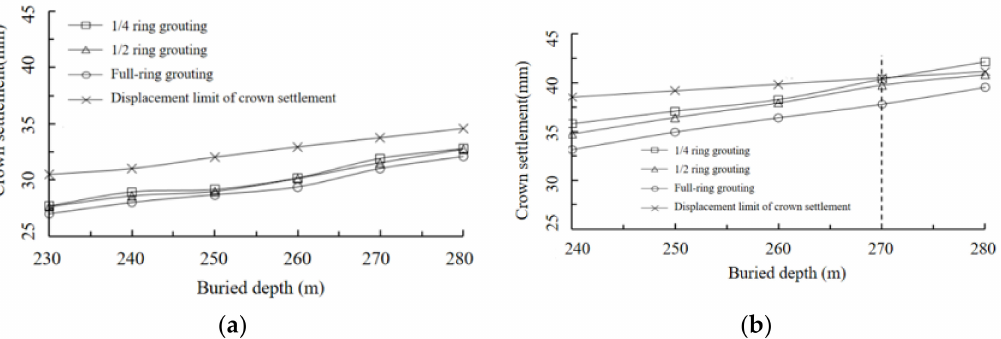
Figure 7. Maximum displacement of crown settlement under different grouting ring ranges and the surrounding rock grades. ( a ) Grade IV surrounding rock; ( b ) Grade V surrounding